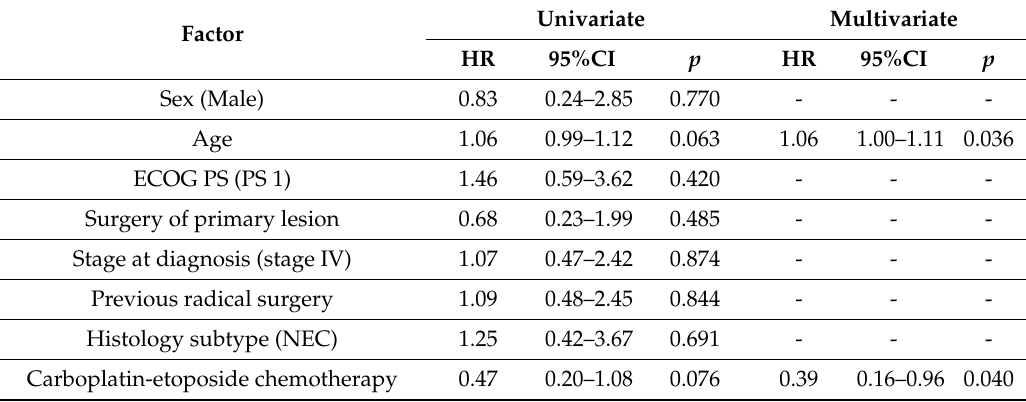
Table 4. Cox proportional hazard models for the risk of progression or